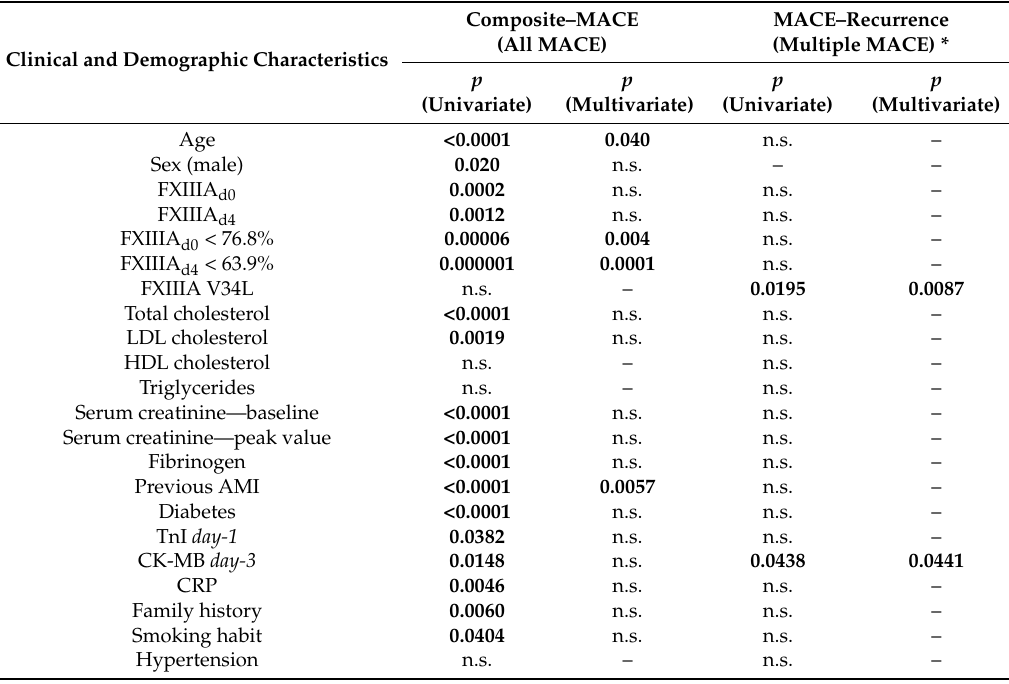
CRP indicates C-reactive protein; CAD indicates coronary artery disease; TnI and CK-MB indicate troponin I and creatine kinase-MB, respectively; FXIIIA d0 < 76.8% and FXIIIA d4 < 63.9% indicate the I quartile of FXIIIA at day-zero and day-four, respectively; n.s. indicates not significant. * indicates two or more MACE.